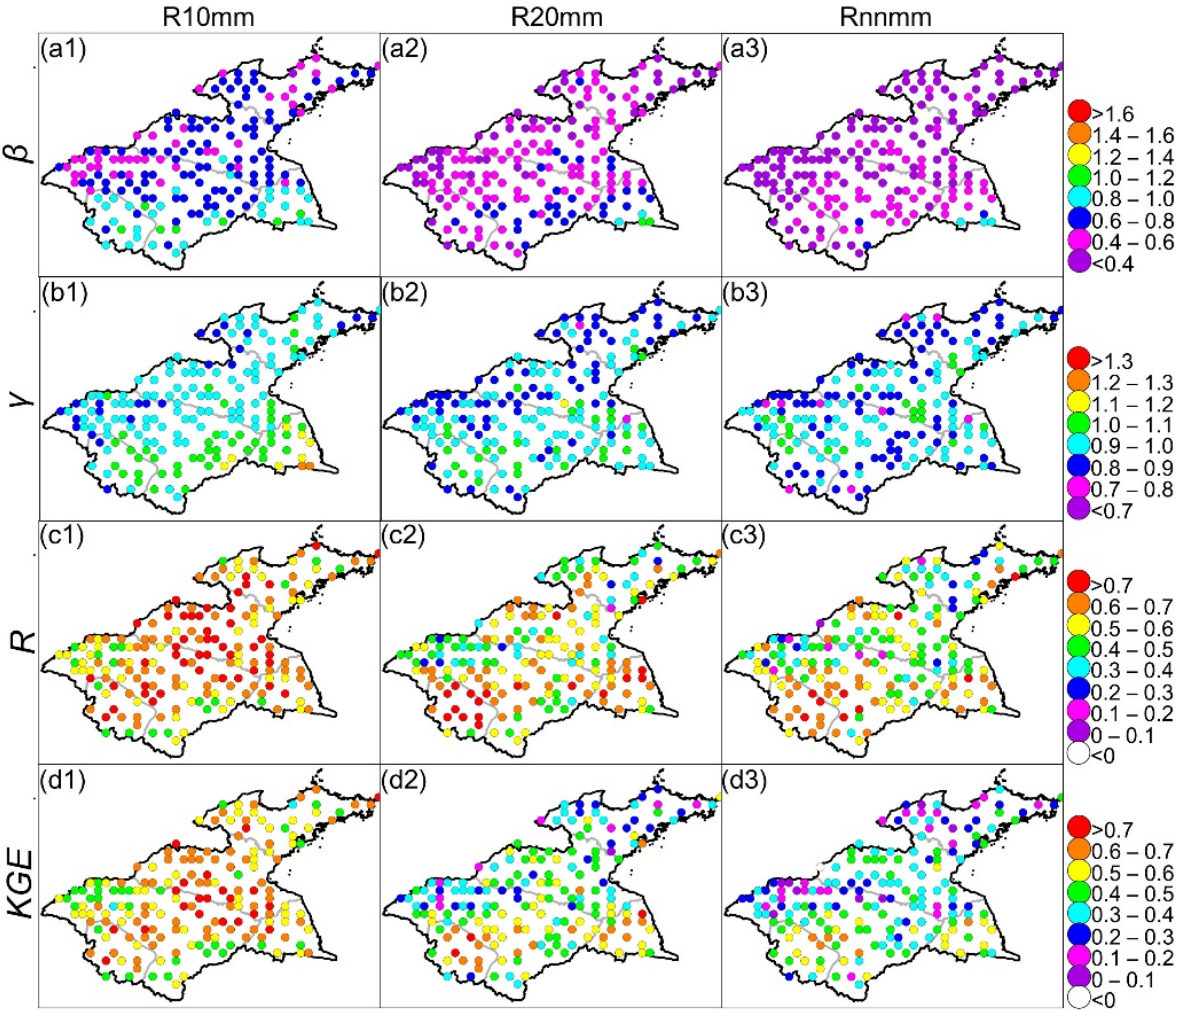
Figure 9. Spatial patterns of different validation metrics for the frequency-based indices.